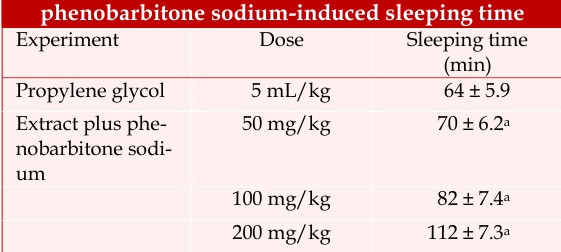
Effect of methanol extract of Careya arborea